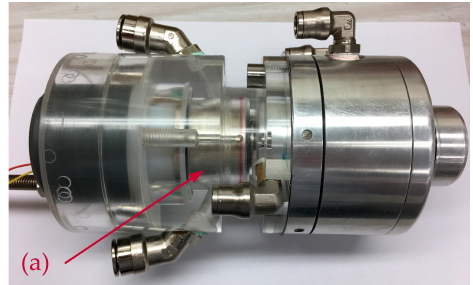
Figure 5. Solid target assembly with target shuttle and SS925 target holder (a).